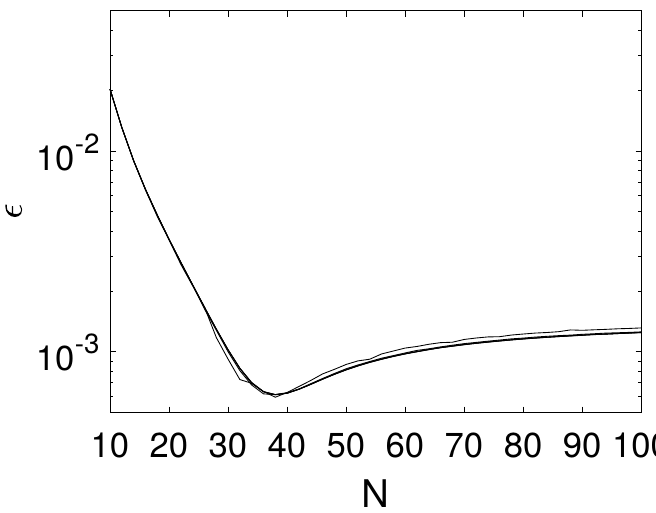
Figure 6. Comparison between analytical and numerical solution for specific initial conditions N ( L , x ,0 ) and a specific output profile ¯ n mill ( L ) of the mill (see text). The relative error (cid:101) is defined as the Frobenius norm of the difference between numerical and analytical solution divided by the Frobenius norm of the analytical solution. The figure shows the error as a function of N for values of M between 20 and